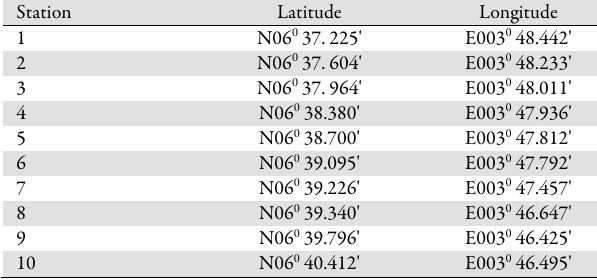
Table 1. Coordinates of different stations at Ibefun Station Latitude